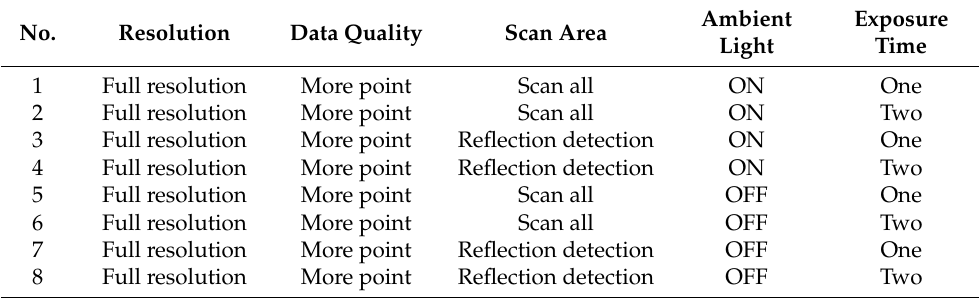
Table 1. Number of test groups and measurement strategy.